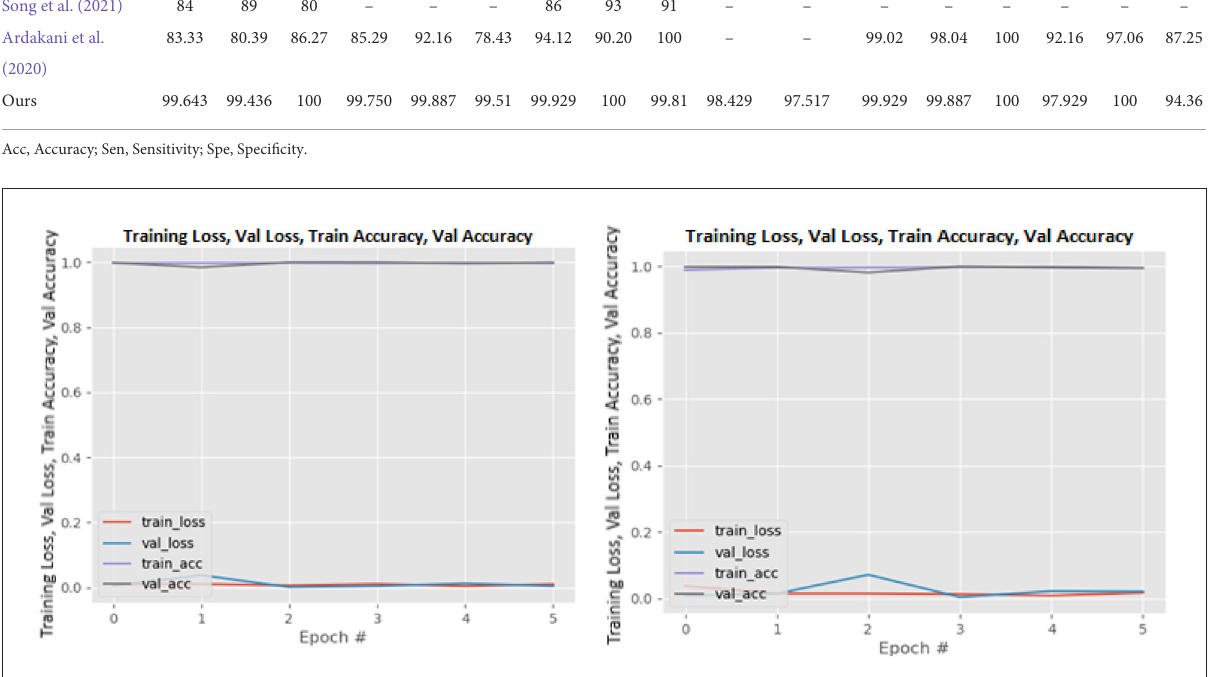
FIGURE8 DenseNet121 without data augmentation (left image) and with data augmentation (right